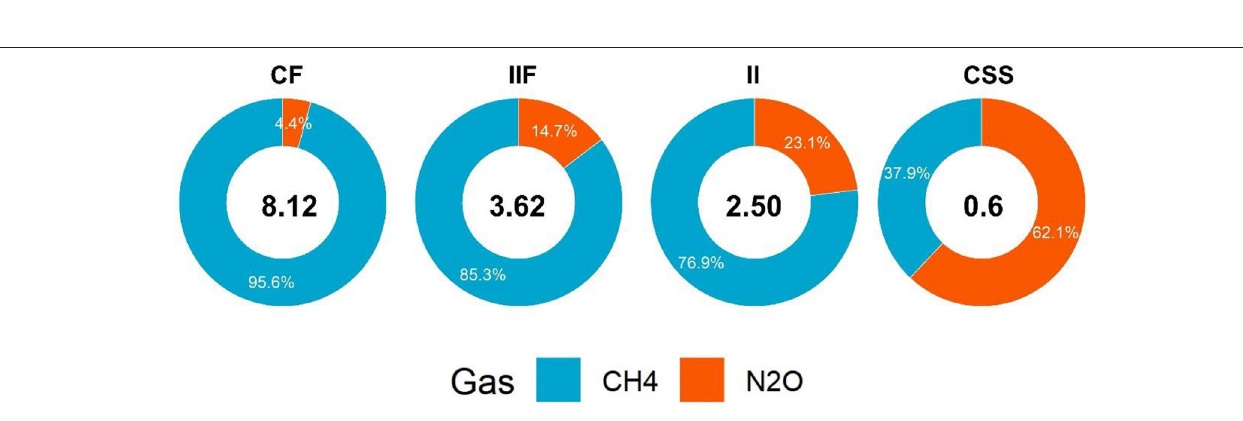
FIGURE 4 | Mean percentage contribution of CH 4 and N 2 O in the overall emissions of rice fields under Continuous Flooding (CF), Intermittent Irrigation (II), and Intermittent irrigation until Flowering (IIF) and Continuous Soil Saturation (CSS) for the period 2014–2019. Numbers in the center of each plot indicate the total seasonal emissions expressed in ton CO 2